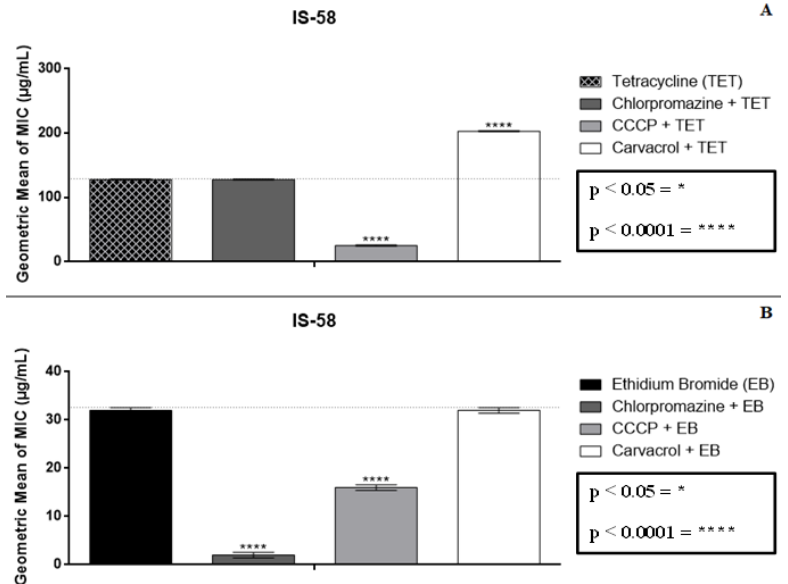
Figure 2. Effect of the association between carvacrol and tetracycline ( A ) and carvacrol and ethidium bromide ( B ) over S. aureus IS-58, expressing the TetK efflux protein. CCCP = carbonyl cyanide m-chlorophenylhydrazone; * p < 0.05; **** p < 0.0001.